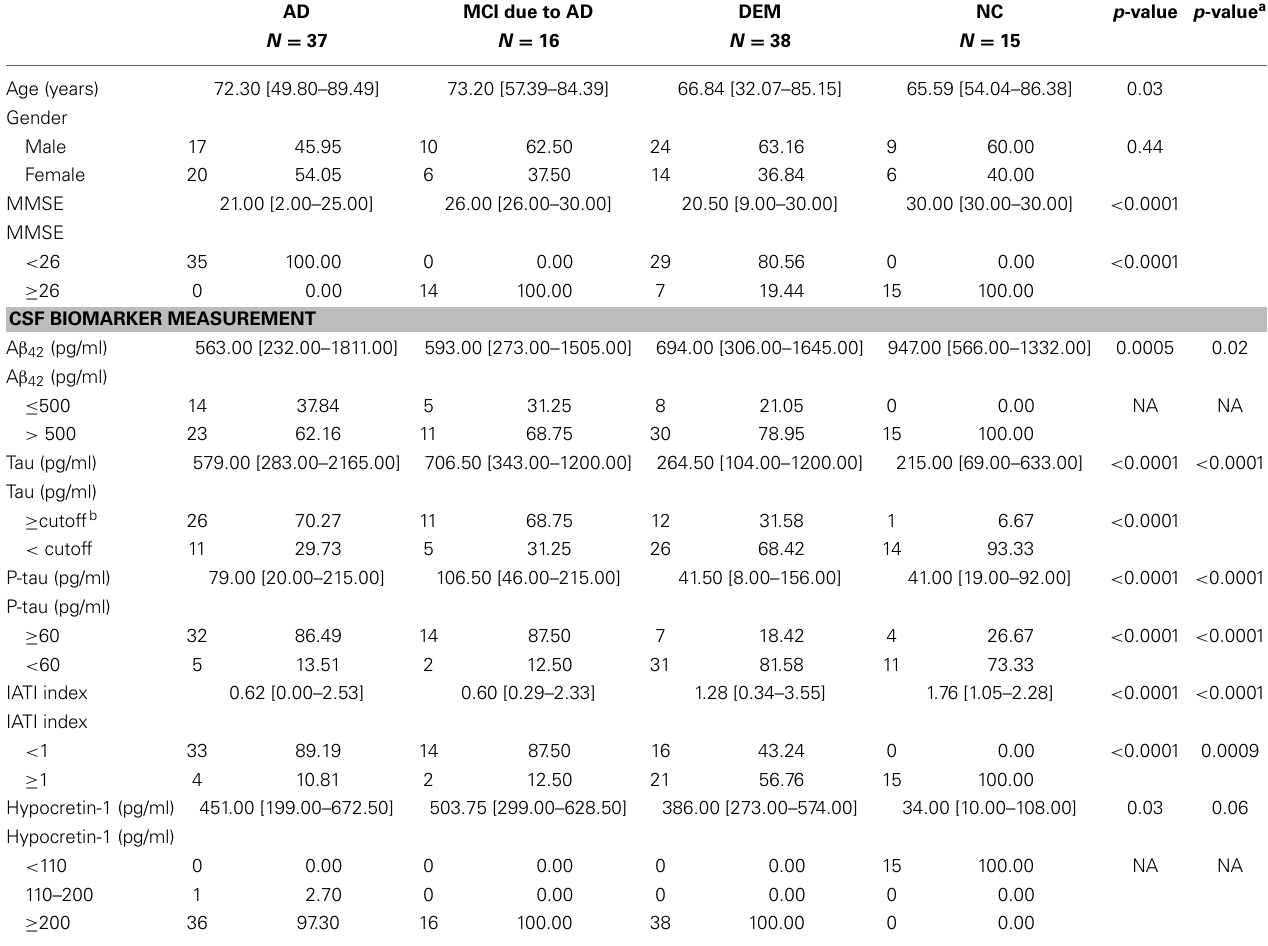
Table 1 | Sociodemographic, clinical, and biological variables for patients with different etiologies of cognitive impairment and patients with